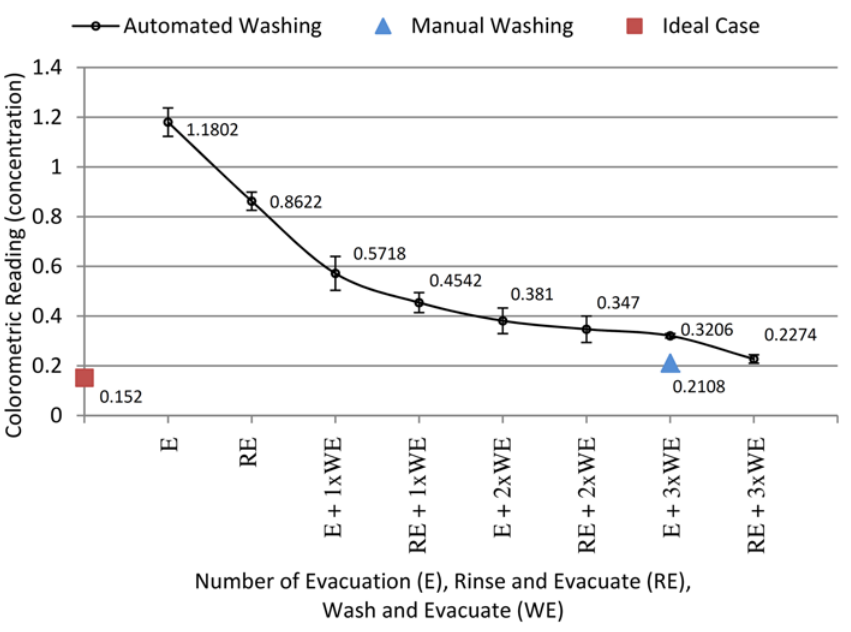
Fig 6. Performance evaluation of push-wash and pull-evacuation. Performance evaluation of implementing evacuation, rinse and wash using push-wash and pull-evacuation in an immunoassay.